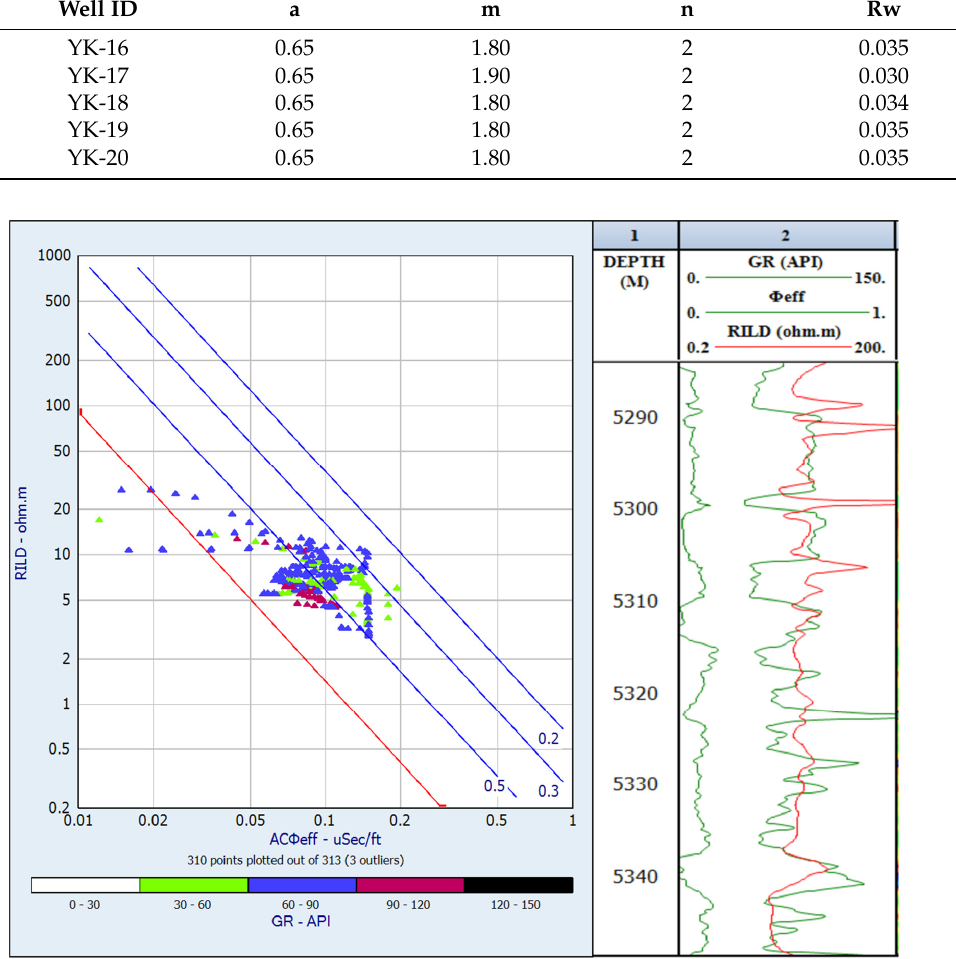
Table 3. Archie parameters for the research area.